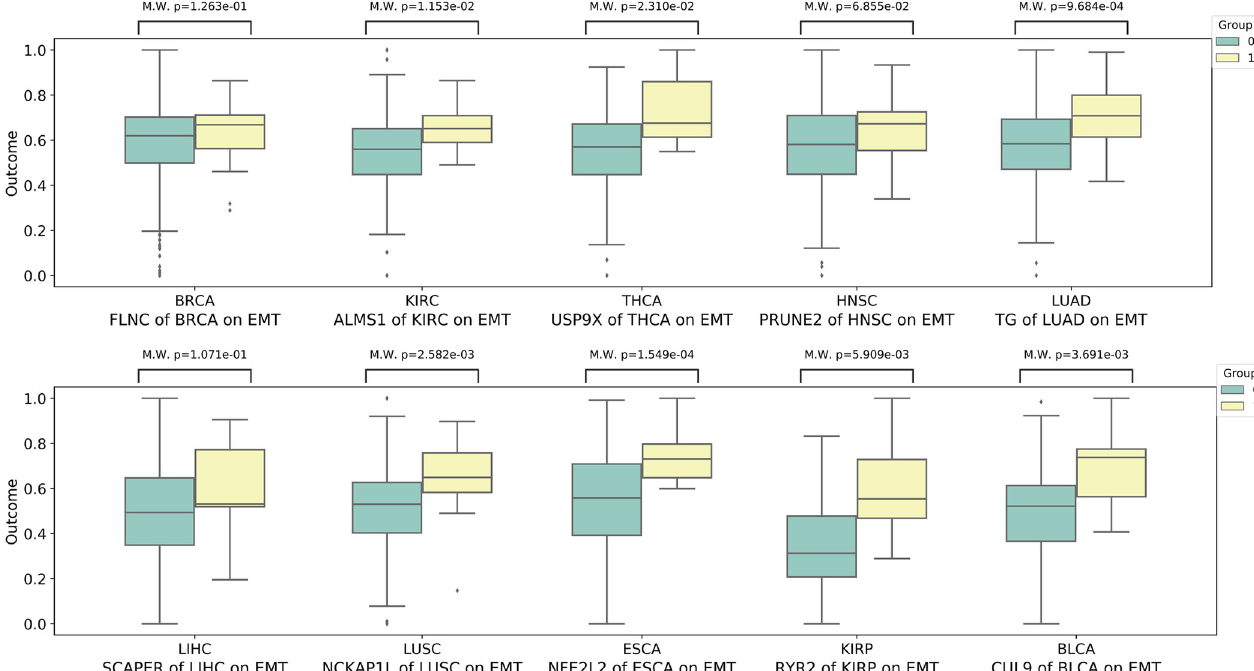
Fig 6. The Mann-Whitney U test (M.W.) analysis reflects the significant differences between mutated groups and non-mutated groups of mutated genes with high ATE values in the activity of EMT process for 10 cancers.